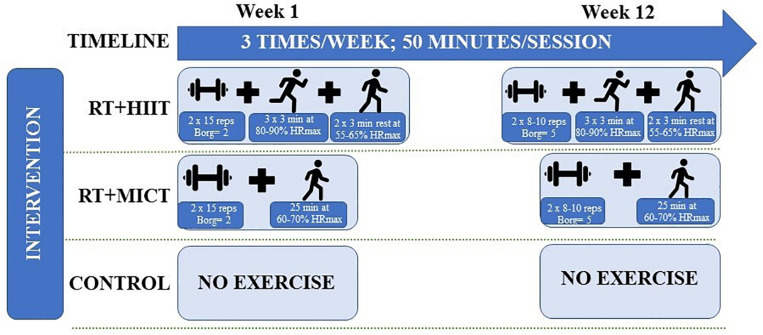
Illustrative scheme of exercise intervention across groups.